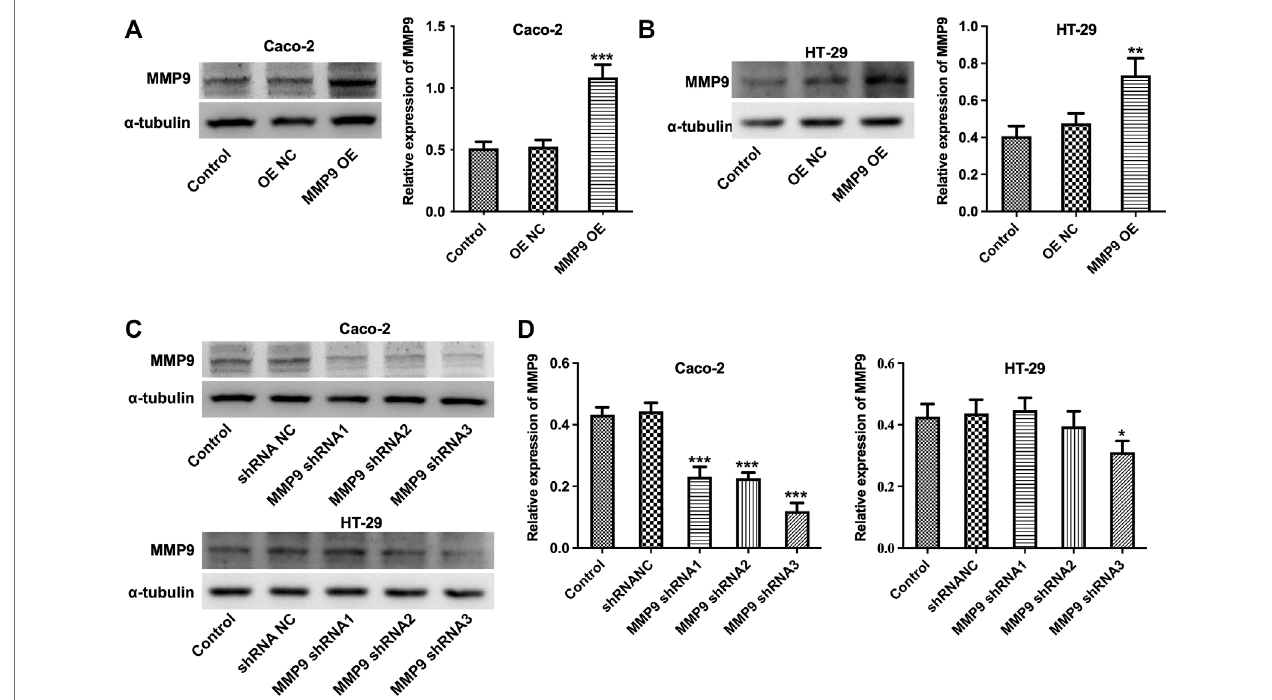
FIGURE 4| Establishment of MMP9 overexpressing and MMP9 knockdown Caco-2 and HT-29 cells. (A,B) Caco-2 and HT-29 cells were transfected with MMP9 OEplasmids. Western blotassaywasusedtodetermine theexpression ofMMP9 incells. ** p < 0.01,*** p < 0.001vs. OENC group. (C,D) Caco-2andHT-29 cellswere transfected with MMP9 shRNA1, MMP9 shRNA2 or MMP9 shRNA3 plasmids. Western blot assay was used to determine the expression of MMP9 in cells. * p < 0.05, *** p < 0.001 vs. shRNA NC group. MMP9, matrix metallopeptidase 9; OE NC, overexpression negative control; shRNA NC, short hairpin RNA negative